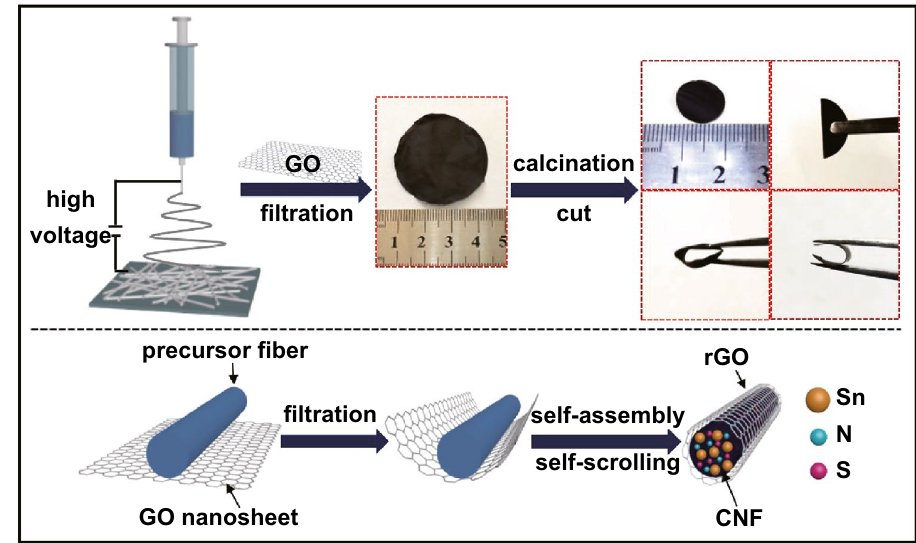
Fig. 1 Schematic illustration of the formation process of Sn/NS‑CNFs@rGO flexible